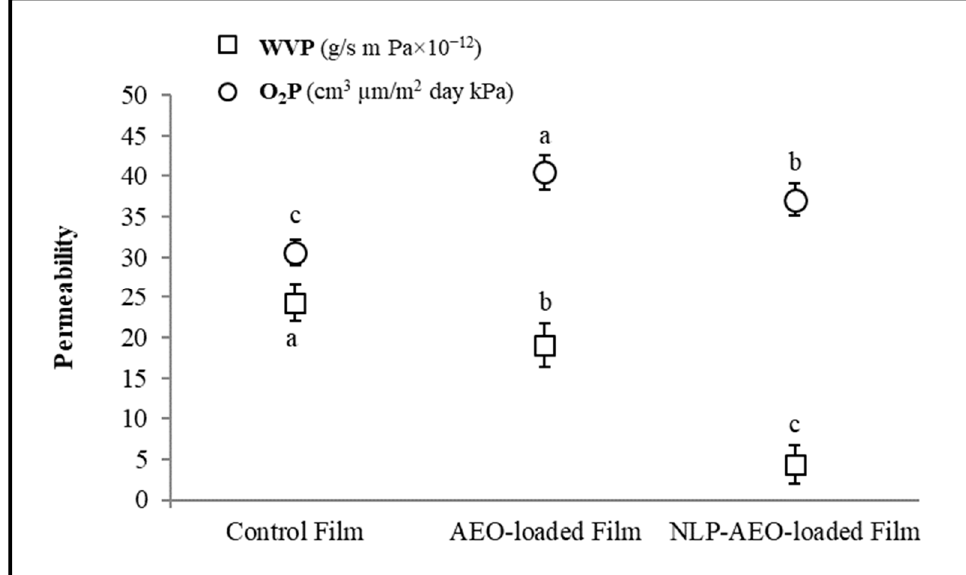
Figure 4. Effect of free and nanoliposomal A EO on permeability properties of Salep mucilage bio- nanocomposite films.